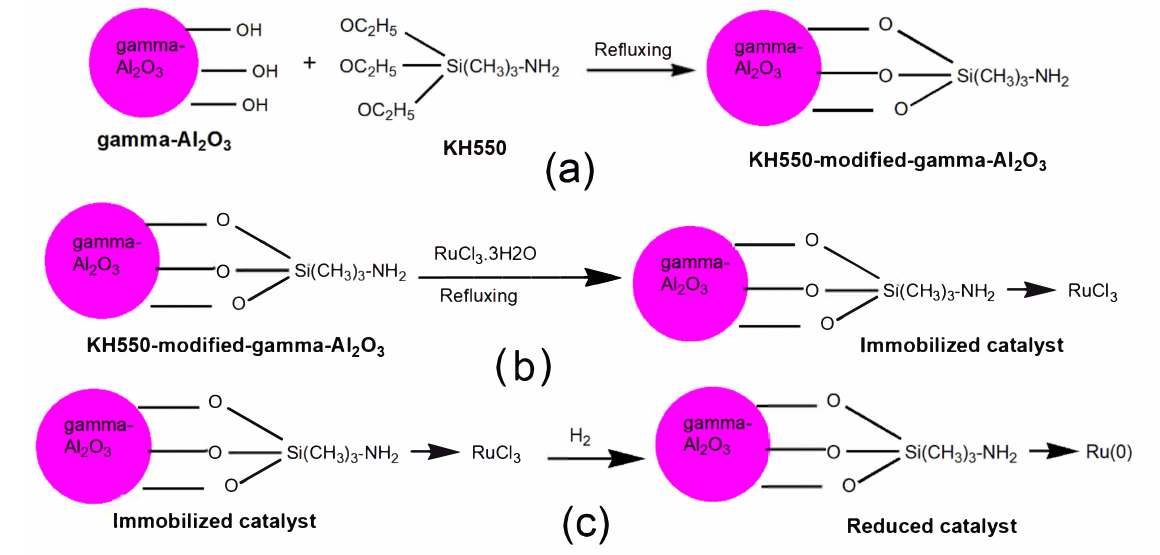
Figure 7. ( a ) Mechanism of surface modification by a silane coupling agent, ( b ) synthesis of the immobilized Ru-based catalyst, and ( c ) reduction of the immobilized Ru-based catalyst. Reproduced from ref [82] with permission from The Royal Society of